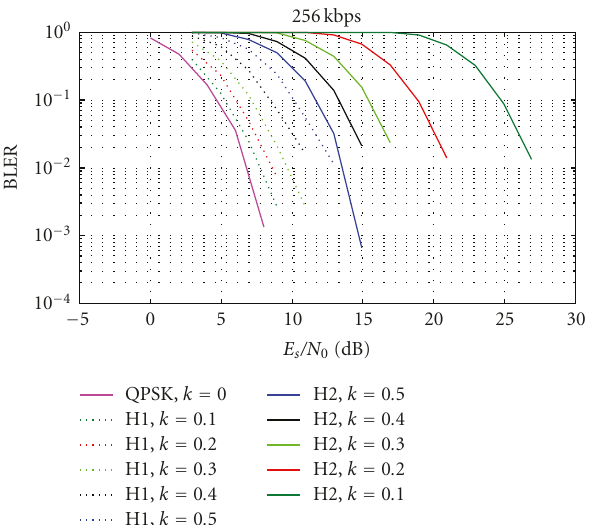
Figure 7: BLER versus E s /N 0 for hierarchical 16-QAM varying k , Rb = 256kbps, VehA 30km/h.